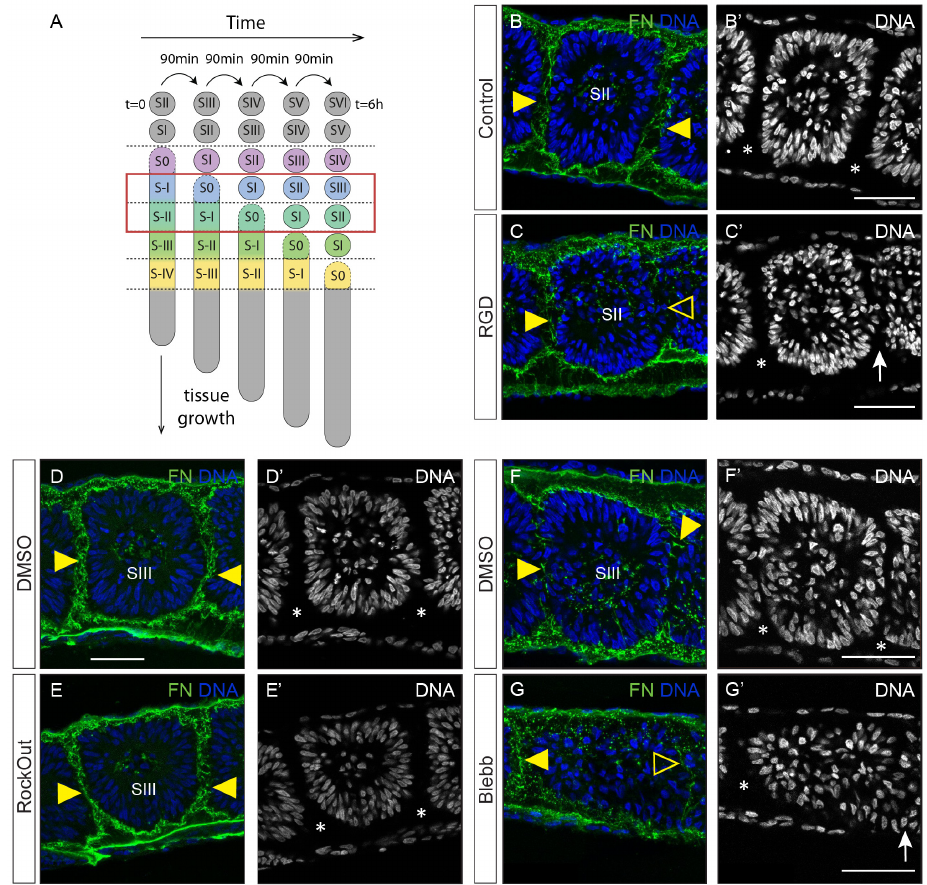
Figure 4. Impact of RGD, RockOut or Blebbistatin treatment on determined PSM segmentation. ( A ) Strategy of analysis: Here we examine the somites SII/SIII after 6 h in culture, which corre-